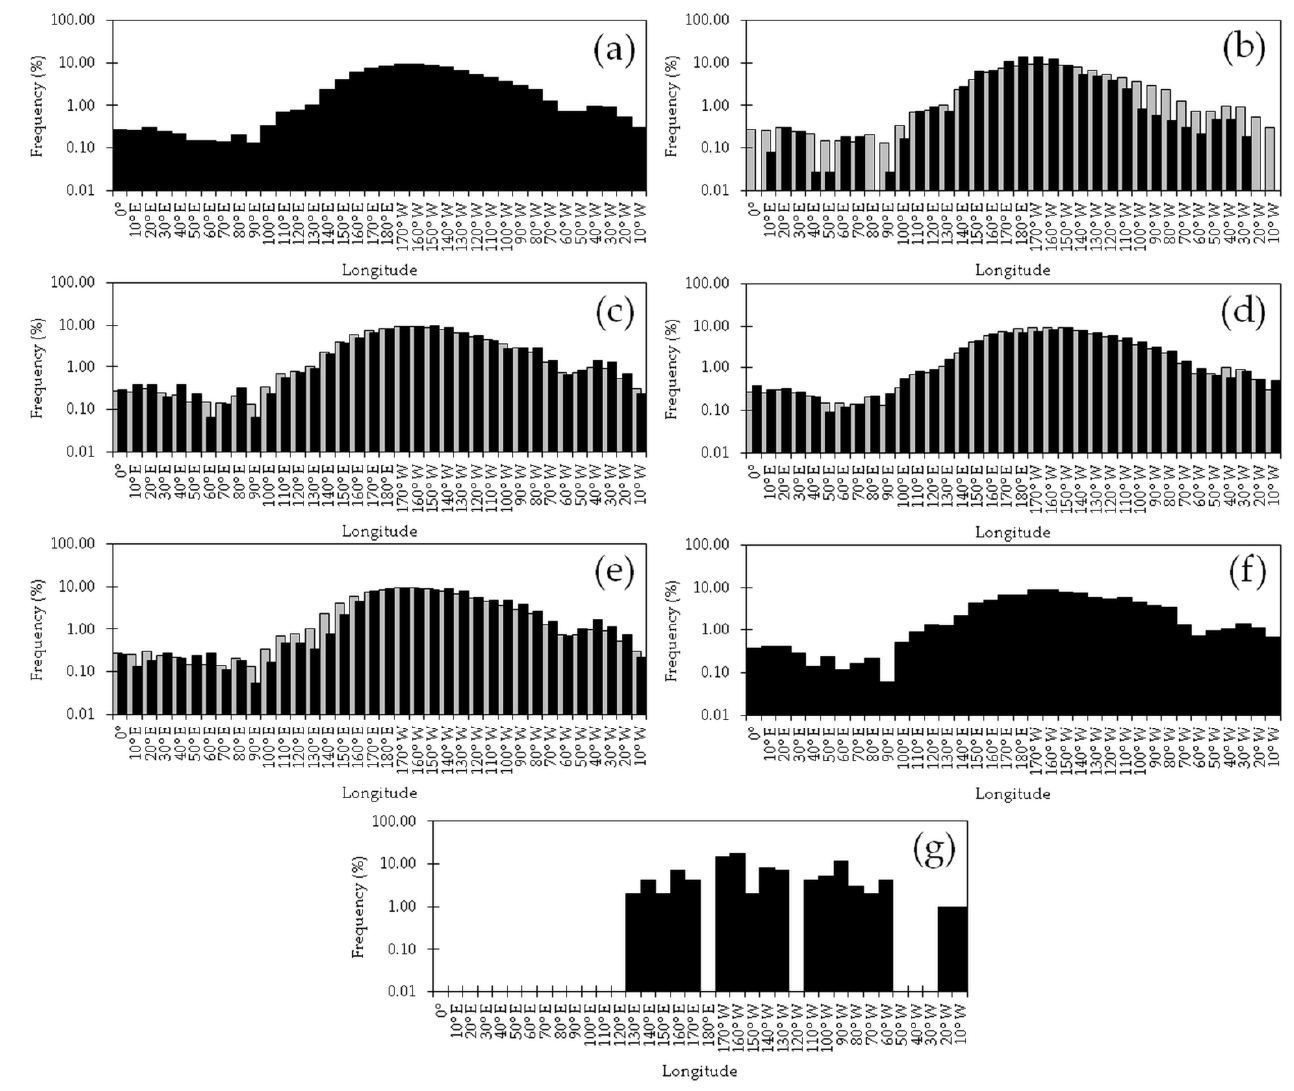
Figure 5. Longitudinal distribution of blocking episodes at 500 hPa within the 74-year period: ( a ) annual; ( b ) DJF; ( c ) MAM; ( d ) JJA; ( e ) SON. The vertical scale is logarithmic. The total number of days was 27,010, 6660, 6808, 6808, and 6734 for the annual, DJF, MAM, JJA, and SON cases, respectively. The grey bars in panels ( b – e ) represent the annual statistics in ( a ) and are presented for comparison purposes. Shown in ( f , g ) are the annual frequencies for values of the BI below − 100 m and − 200 m, respectively. All the frequencies are relative to the corresponding panel’s totals. Individual dates were counted regardless of the duration of the episodes. The skewness coefficients of these distributions are: ( a ) 0.95; ( b ) 1.56; ( c ) 1.06; ( d ) 0.75; ( e ) 0.93; ( f ) 0.77; ( g ) 1.89.